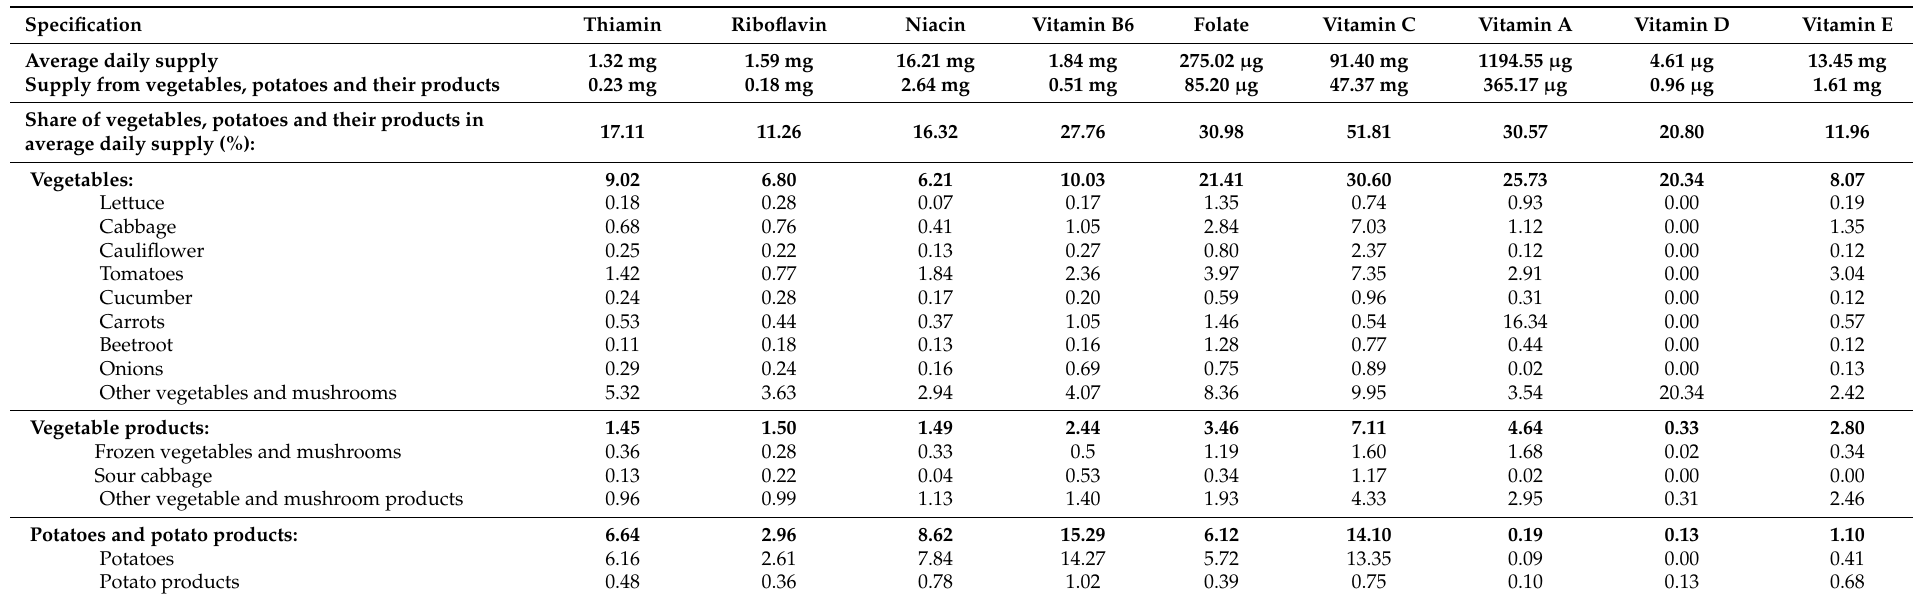
Table 4. Vegetables, potatoes and their products as sources of vitamins in the